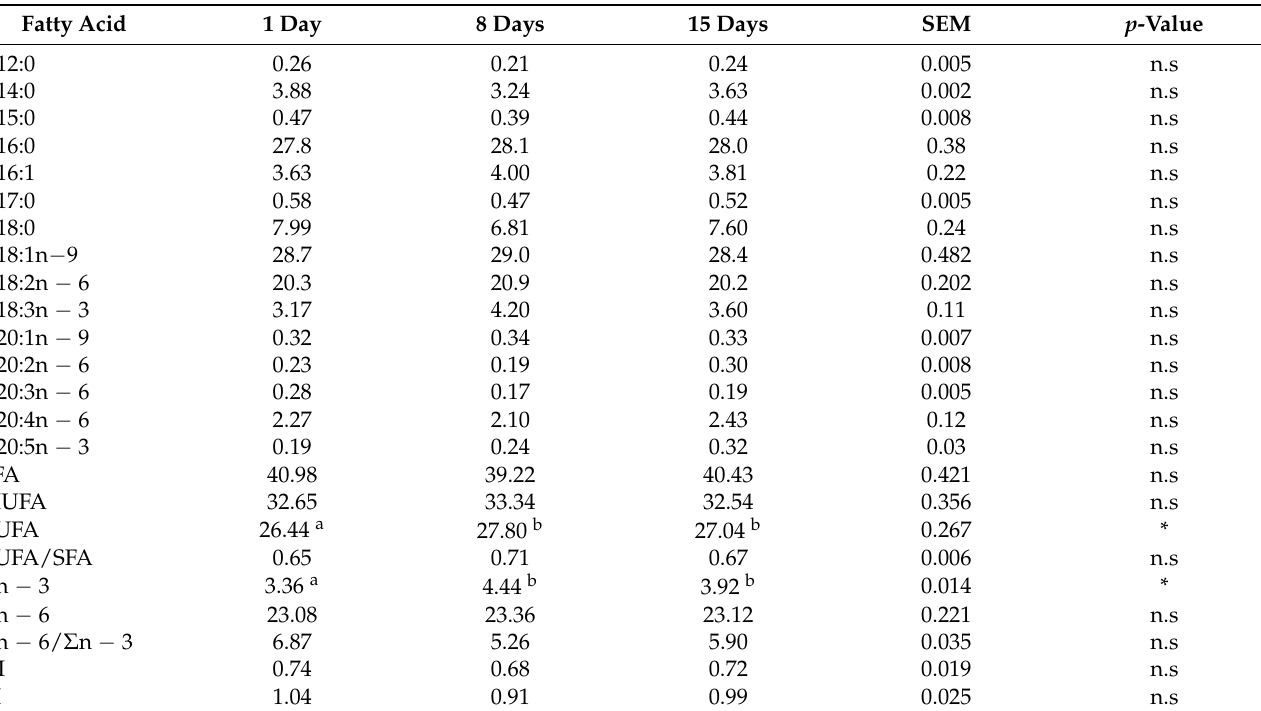
Table 2. Fatty acid composition (% total fatty acids) determined in donkey muscle. LTL aged for 1, 8, and 15